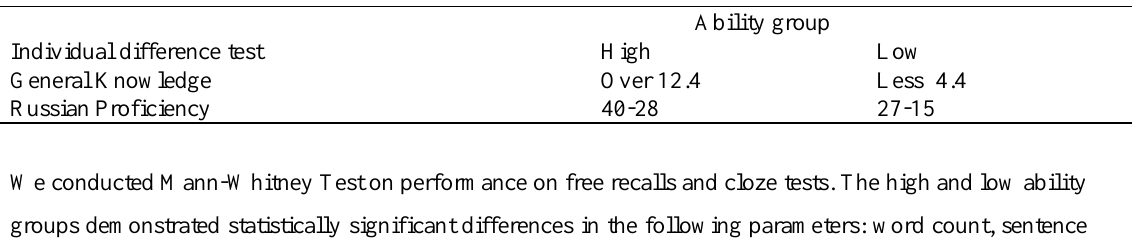
Table 4. Mean Scores for Participants Assigned to the Low and High Groups